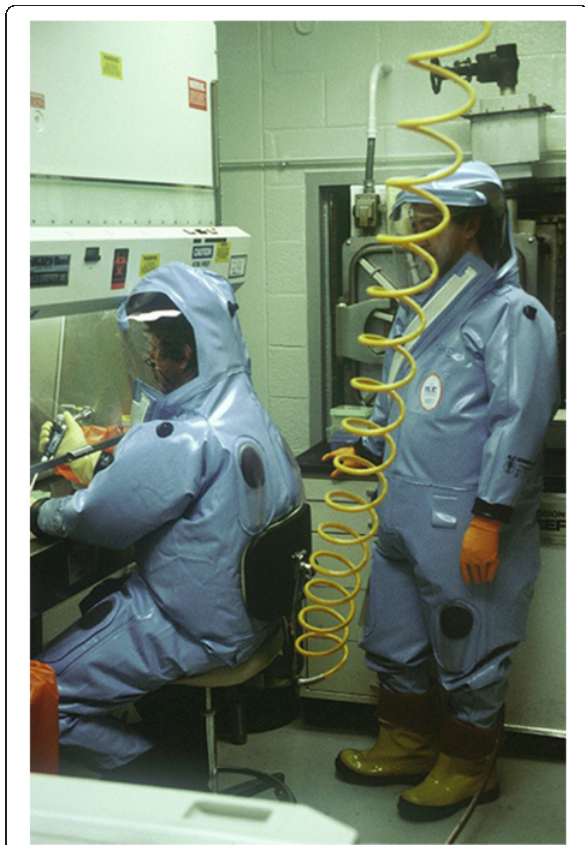
Figure 3 Study of Ebola virus in a high-security laboratory BSL-4 (photo by IRD,